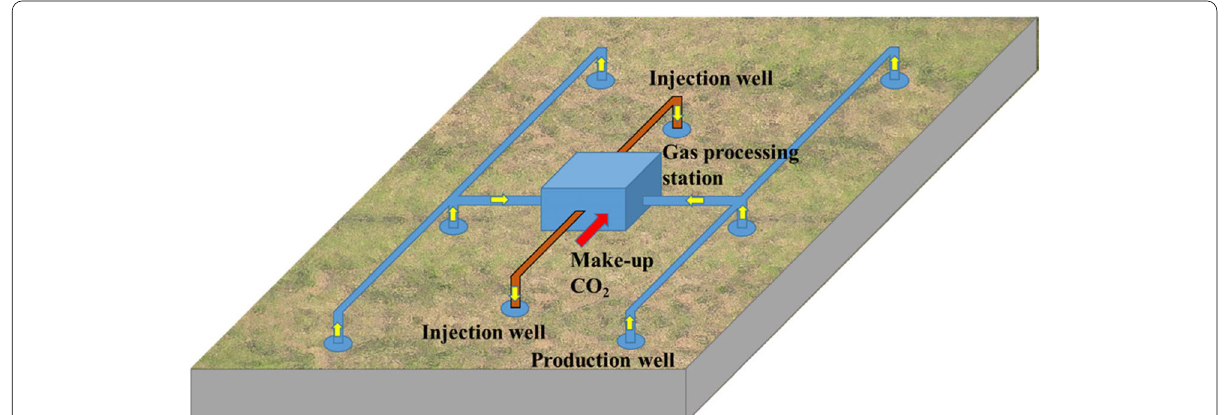
Fig. 6 Schematic diagram of the design of the multi‑well combined injection and production (MWCIP)